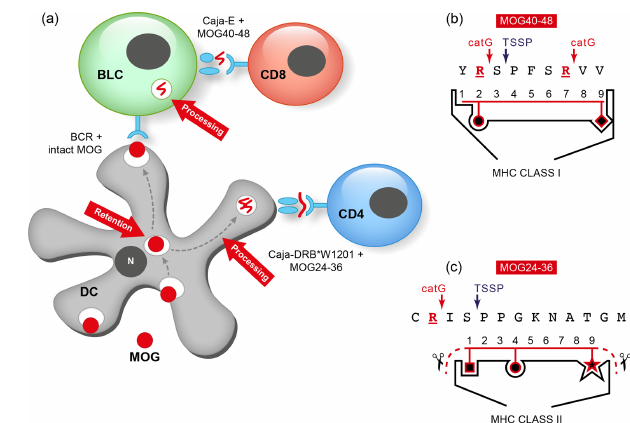
Figure 11. Concept for T cell activation within the CLNs . (a) MOG draining via interstitial fluid (ISF) or cerebrospinal fluid (CSF) to the CLNs is captured by DC-like phagocytic cells (de Vos et al., 2002). (b, c) T cells against the two dominant epitopes (24–36 and 40–48) are probably not deleted during thymic negative selection as both epitopes are vulnerable to destruction by TSSP, which cleaves at SP/PP residues present in both epitopes (Serre et al., 2017). Pro- cessing of MOG in myeloid APCs and B cells is led by catG, which cleaves at arginine ( R ) residues (Jagessar et al., 2016). This mech- anism prevents peripheral activation of autoaggressive T cells that have escaped thymic selection. (b) The peptide sequence left af- ter cleavage of the MOG40-48 epitope at Arg 41 and Arg 46 (the 4-mer 42–45) is too short for filling the peptide-binding cleft of the MHC class I molecule. In the BLC, however, the MOG40-48 epitope is protected against destructive processing. (c) Cleavage of the MOG24-36 epitope at Arg 25 may have little effect as a peptide of sufficient length (the 9-mer 26–34) is left intact for filling the peptide-binding cleft of the MHC class II